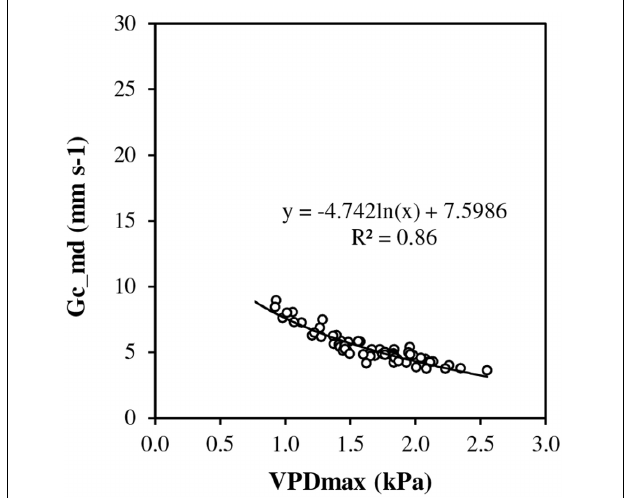
FIGURE 3 | Midday canopy conductance ( G c _md ) vs. maximum vapor pressure deficit ( VPD max ) at full canopy period and in the absence of soil water stress ( REW 0–0.6 ≥ 0.5).